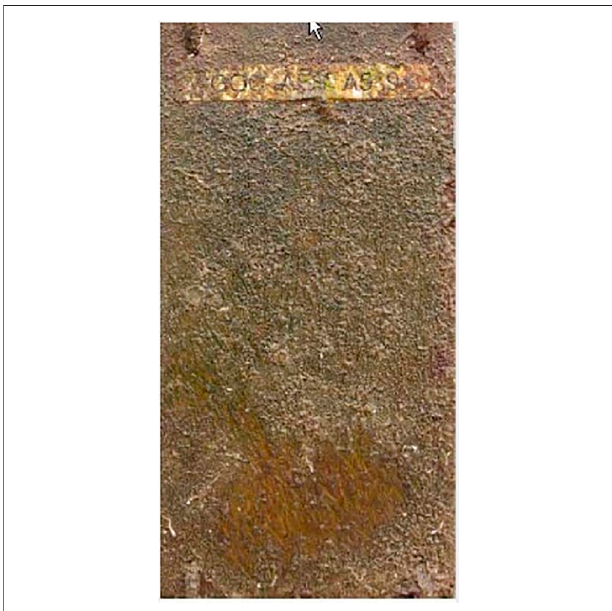
FIGURE 3 | Sample with copper oxide nanocontainers loaded with SeaNine © incorporated into Re-Turn paints exposed to the seaport in